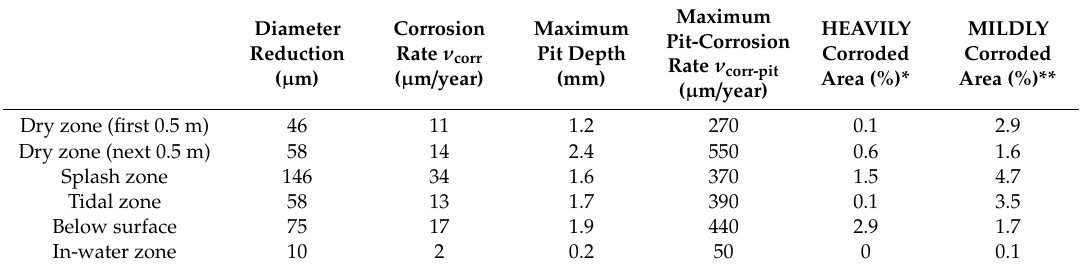
Table 3. Corrosion evaluation of the carbon steel rebar in concrete column